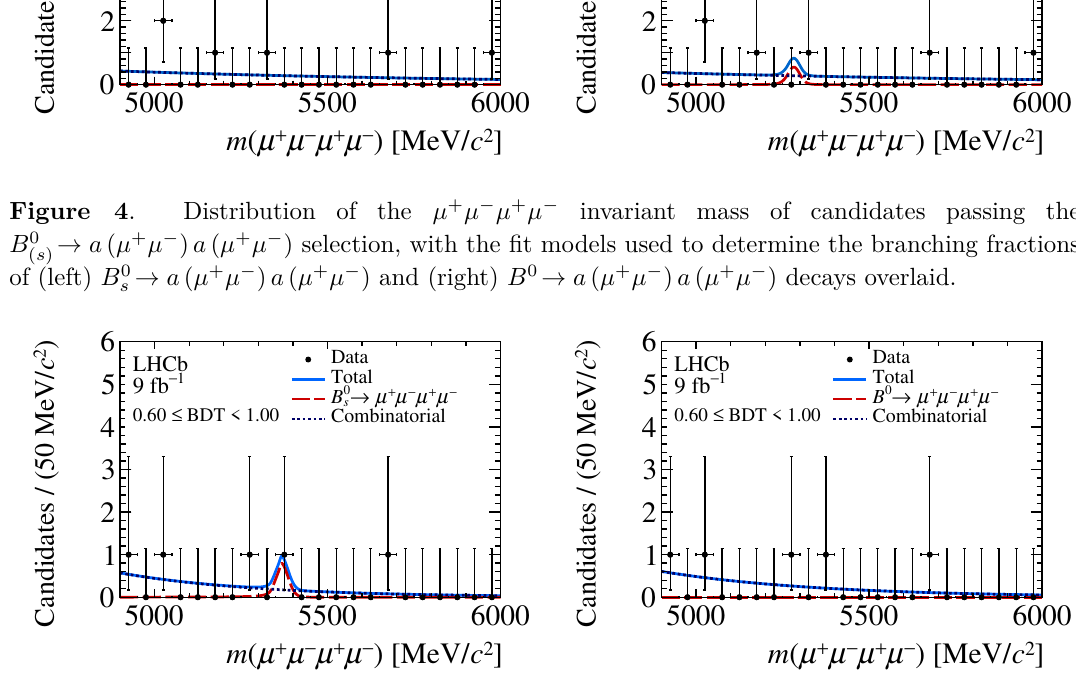
→ µ + µ − µ + µ − and (right) B 0 → µ + µ − µ + µ − decays s